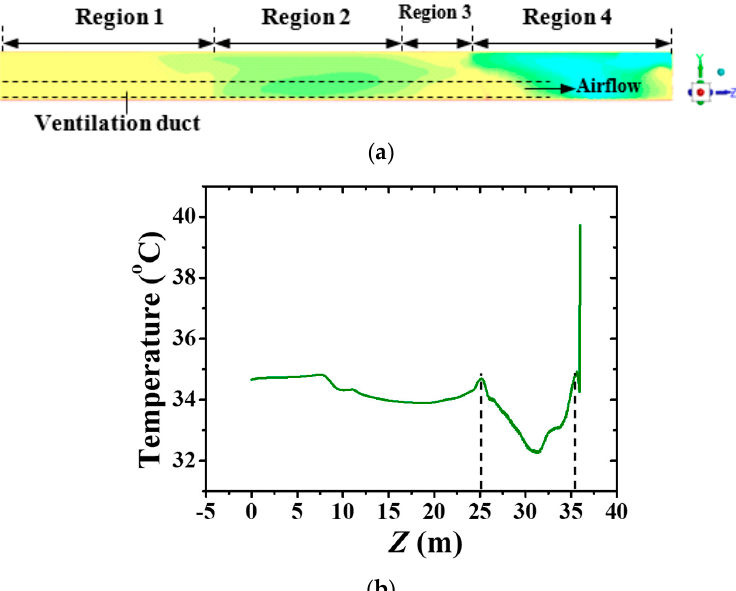
Figure 5. Temperature distribution of airflow in the cooling region for the heading face cooled only by forced ventilation: ( a ) temperature contour at the plane of X = 1.25 m; ( b ) variation of the temperature with the Z axis at the line of X = 1.25 m, Y = 1.5 m.